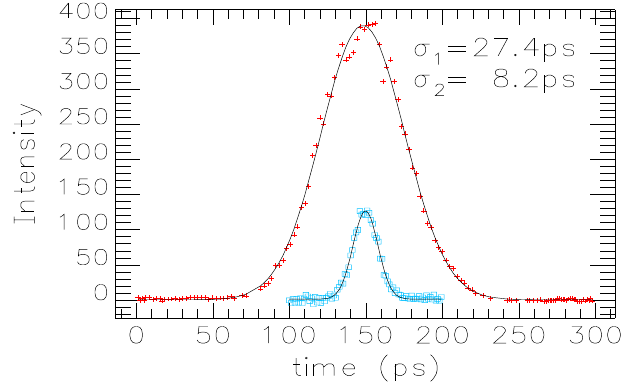
FIG. 8. (Color) The average length of the slitted pulse when the time jitter is